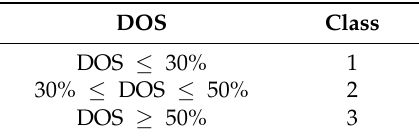
Table 2. Class partition based on DOS [14].